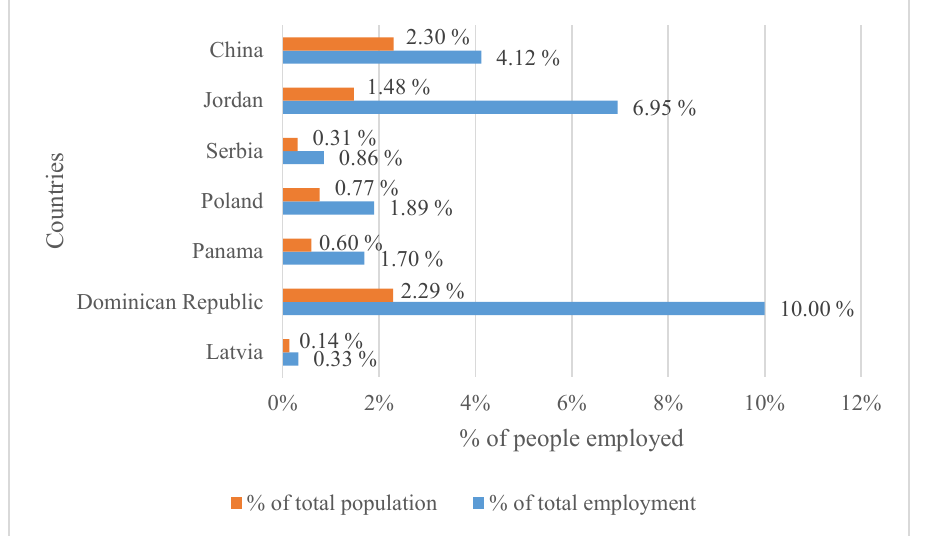
Fig. 1. The number of people employed by the SEZs,